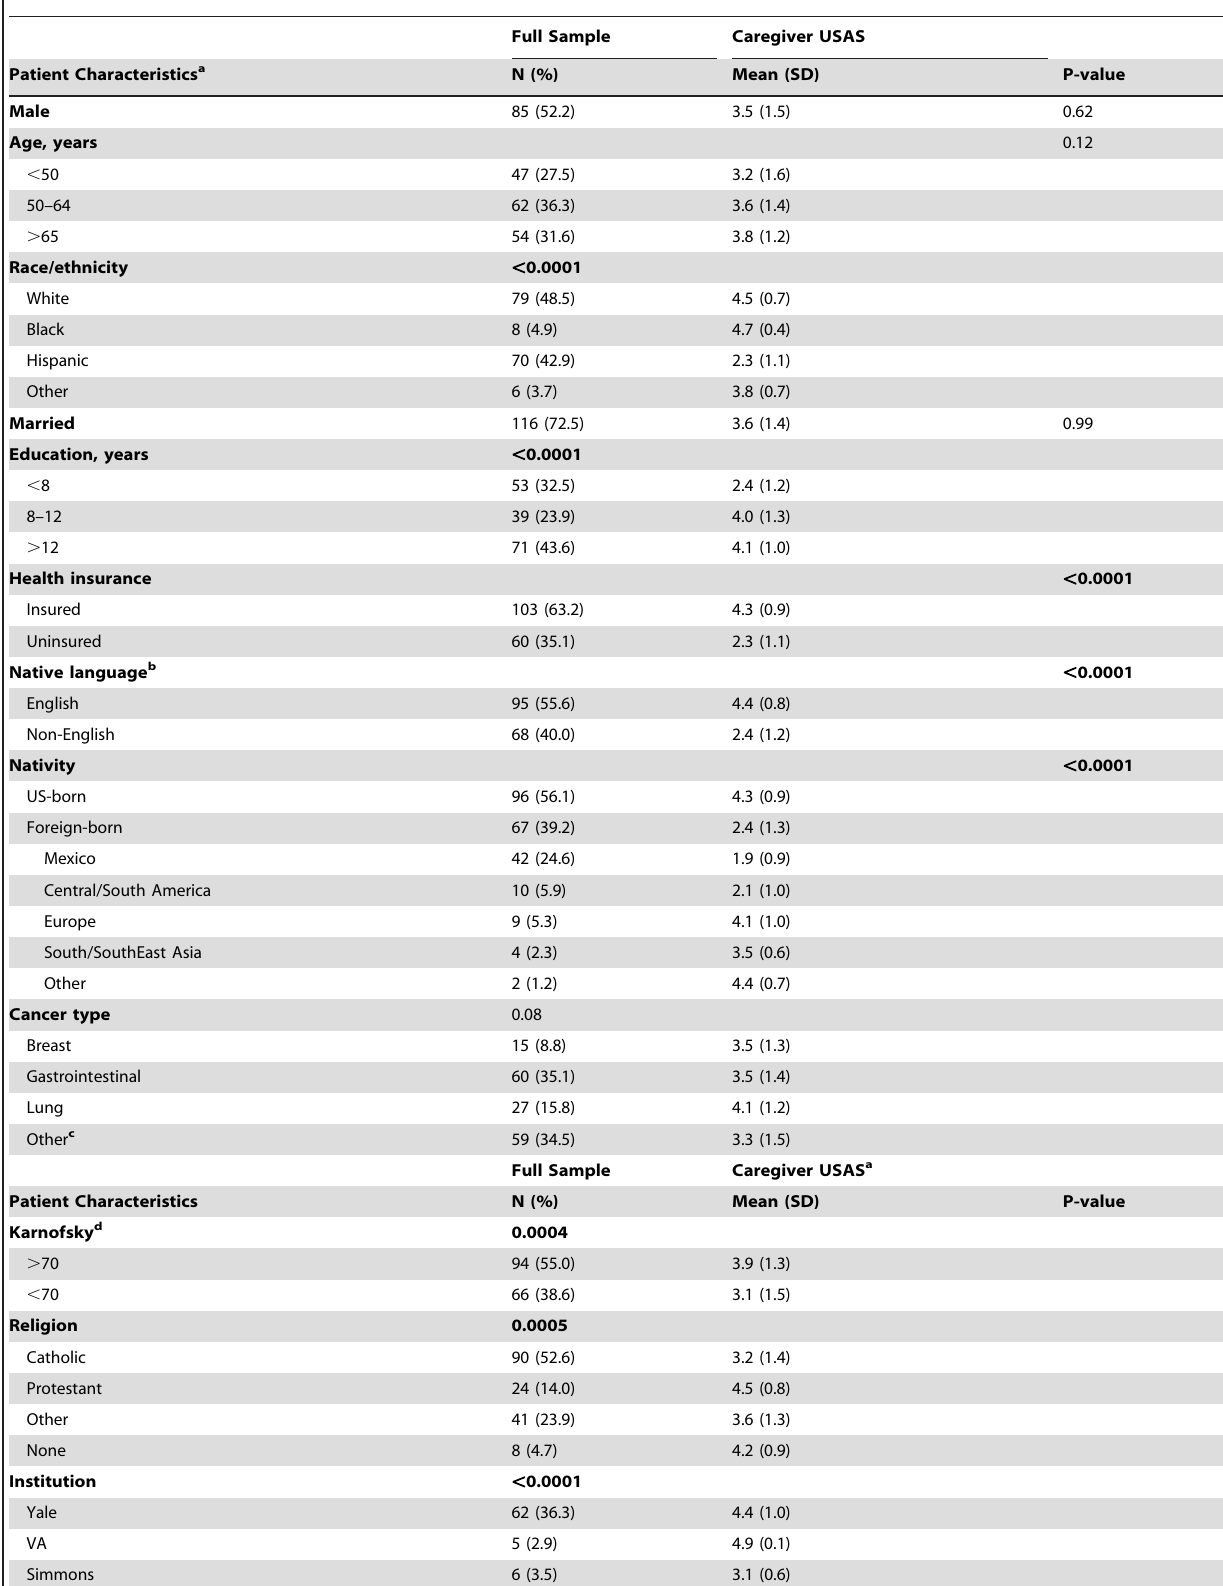
Table 2. Patient characteristics by caregiver acculturation level (N